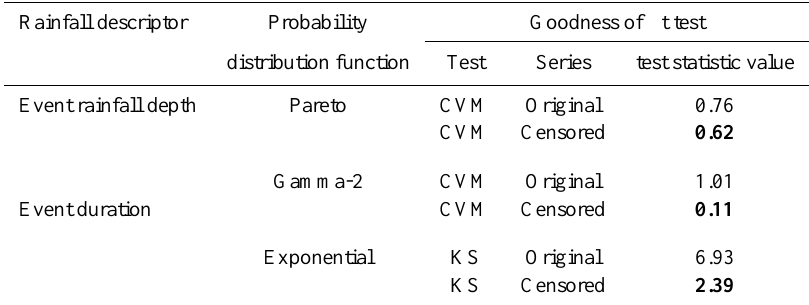
Table 3. Goodness of fit statistic values ( p -value) for original and censored rainfall series.